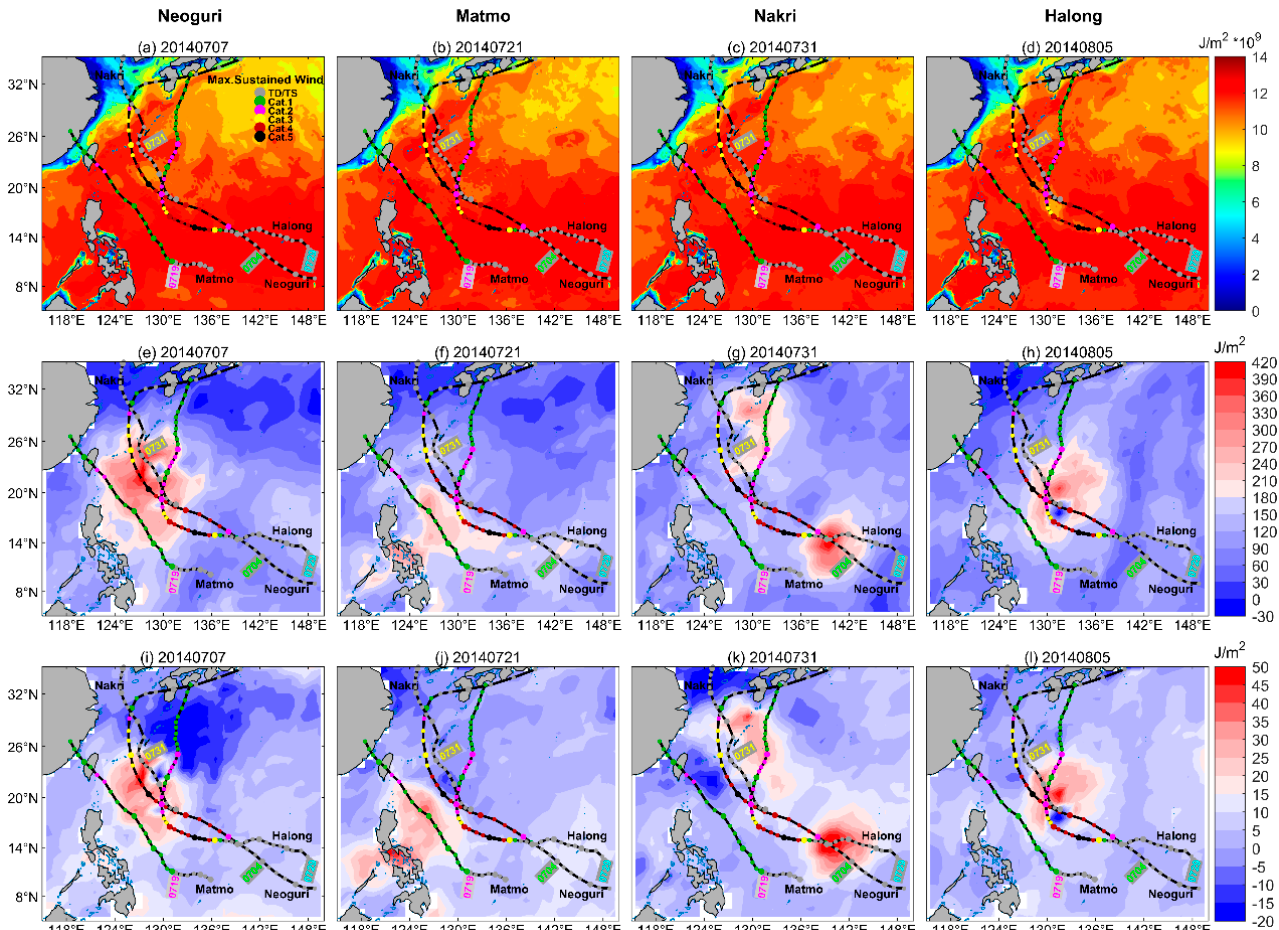
Figure 9. The fields of ( a – d ) ocean heat content, ( e – h ) sensible heat flux and ( i – l ) latent heat flux during the passage of four sequential TCs. The colored lines represented the TC tracks.